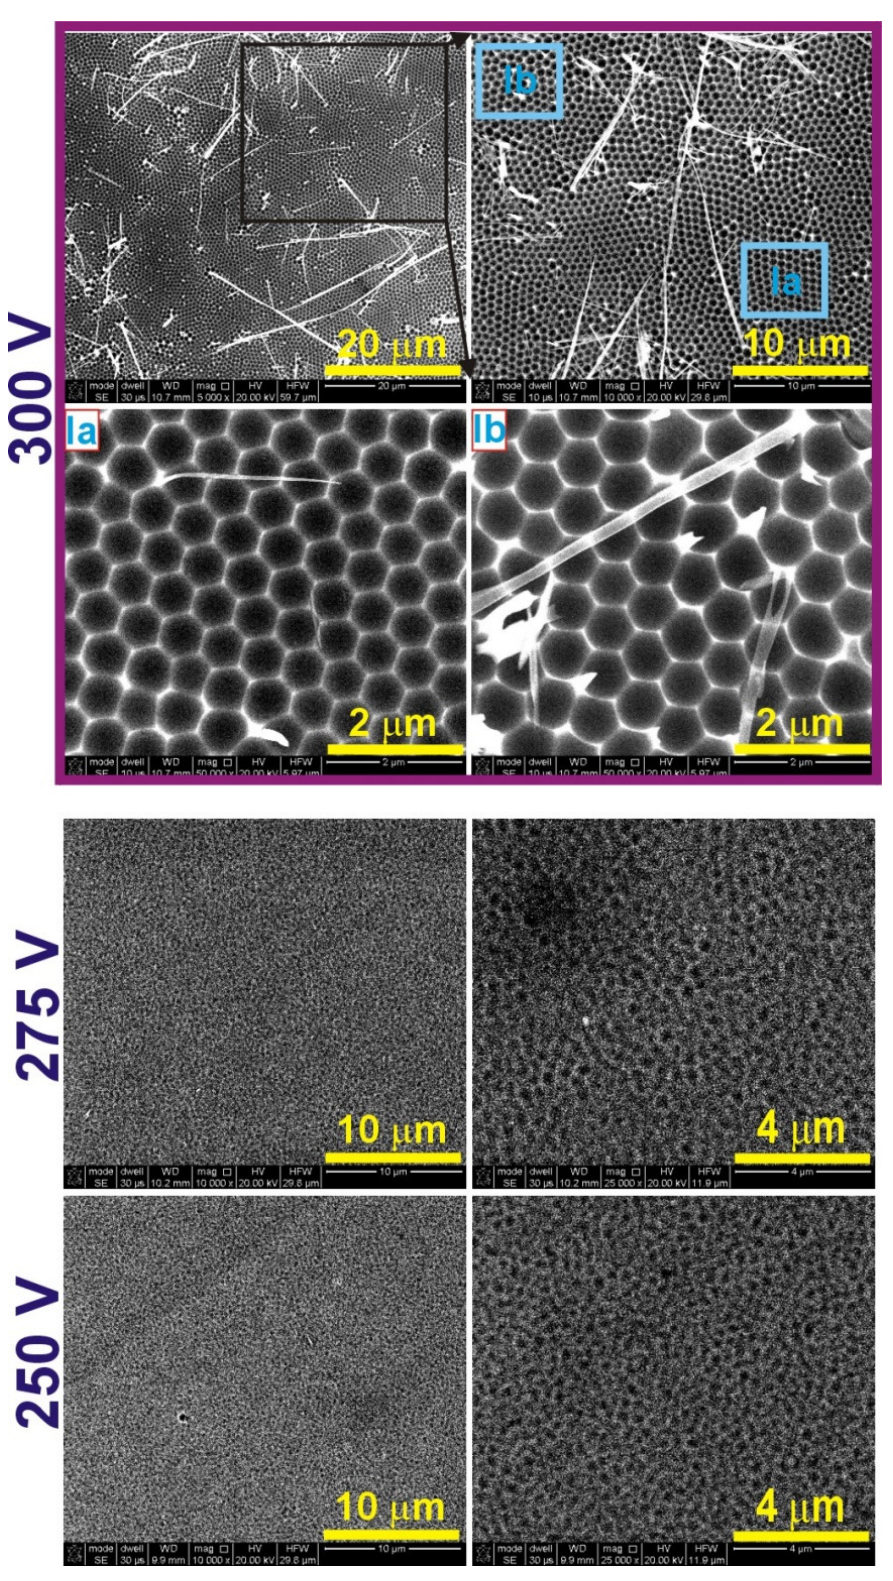
Figure 8. SEM images of the Al substrates after the dissolution of the oxide obtained during anodization in 1.5 M citric acid solution at 5 °C and various anodizing voltages (the SEM images in the right column of the samples anodized at 275 and 250 V are larger magnifications of the respective images in the left column).